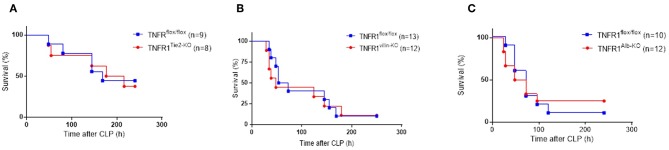
Study on the role of TNFR1 in endothelium, gut epithelium, and hepatocytes using conditional knock-out mice in the cecal ligation and puncture model. Male TNFR1flox/flox and cell-specific conditional TNFR1−/− mice were subjected to CLP. Survival was monitored for 10 days in (A) endothelium (TNFR1Tie2−KO) (n = 8), (B) gut epithelium (TNFR1Villin−KO) (n = 12) and (C) hepatocyte (TNFR1Alb−KO) specific (n = 12) knockout mice, and compared with TNFR1flox/flox mice (n = 9, 13, and 10, respectively).